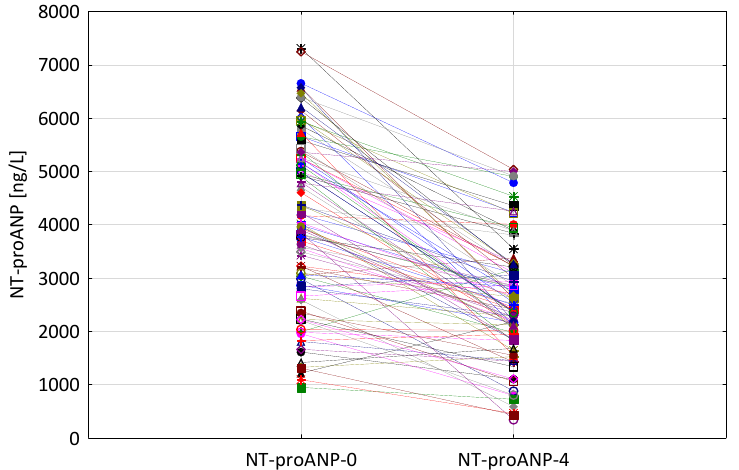
Figure 1. The comparison of NT-proANP concentrations on admission (NT-proANP-0) and on the 4th day of hospitalization (NT-proANP-4) in individual patients. The occurrence of most CAD risk factors (hypertension, diabetes, smoking status, obesity, family history of cardiovascular diseases), history of previous MI, sex, heart rate, systolic blood pressure and administered therapy did not affect NT-proANP levels (Table 3). Table 3. Association between patient characteristics and NT-proANP concentrations on admission (NT-proANP-0) and on the 4th day of hospitalization (NT-proANP-4).